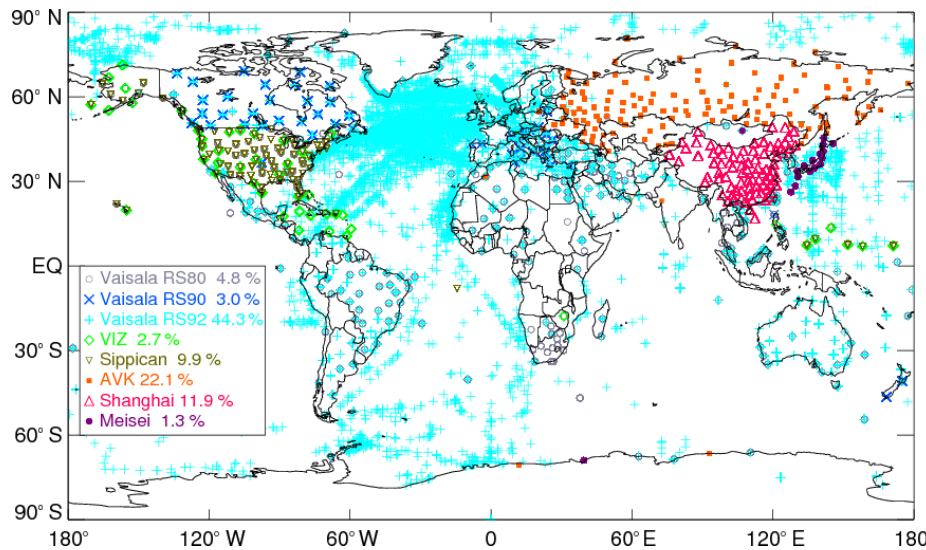
Figure 1. Global distribution of radiosonde stations colored by radiosonde types. Radiosonde types updated from June 2006 to April 2014 are used. The percentage of each type of radiosonde used among all stations is listed. For those stations that radiosonde types are changed during this period, the latest updated radiosonde type is used in this plot. Vaisala RS92 ship observations contain less than 3% of the total RS92